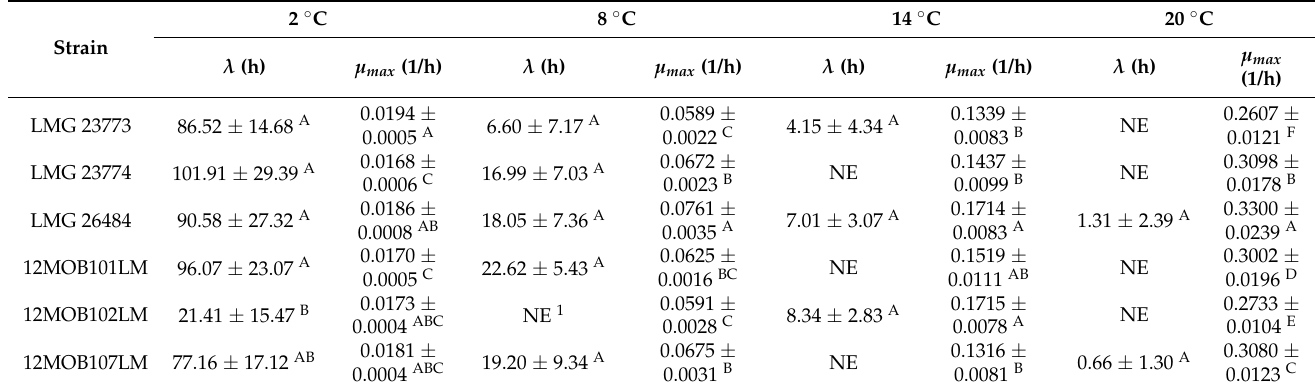
Table 1. Kinetic parameters ± standard errors estimated by the model of Baranyi and Roberts [25] for the growth of six L. monocytogenes strains in smoked salmon pâté at 2, 8, 14, and 20 °C. For the different strains at the same temperature, the values bearing different uppercase letters are significantly different ( p ≤ 0.05).